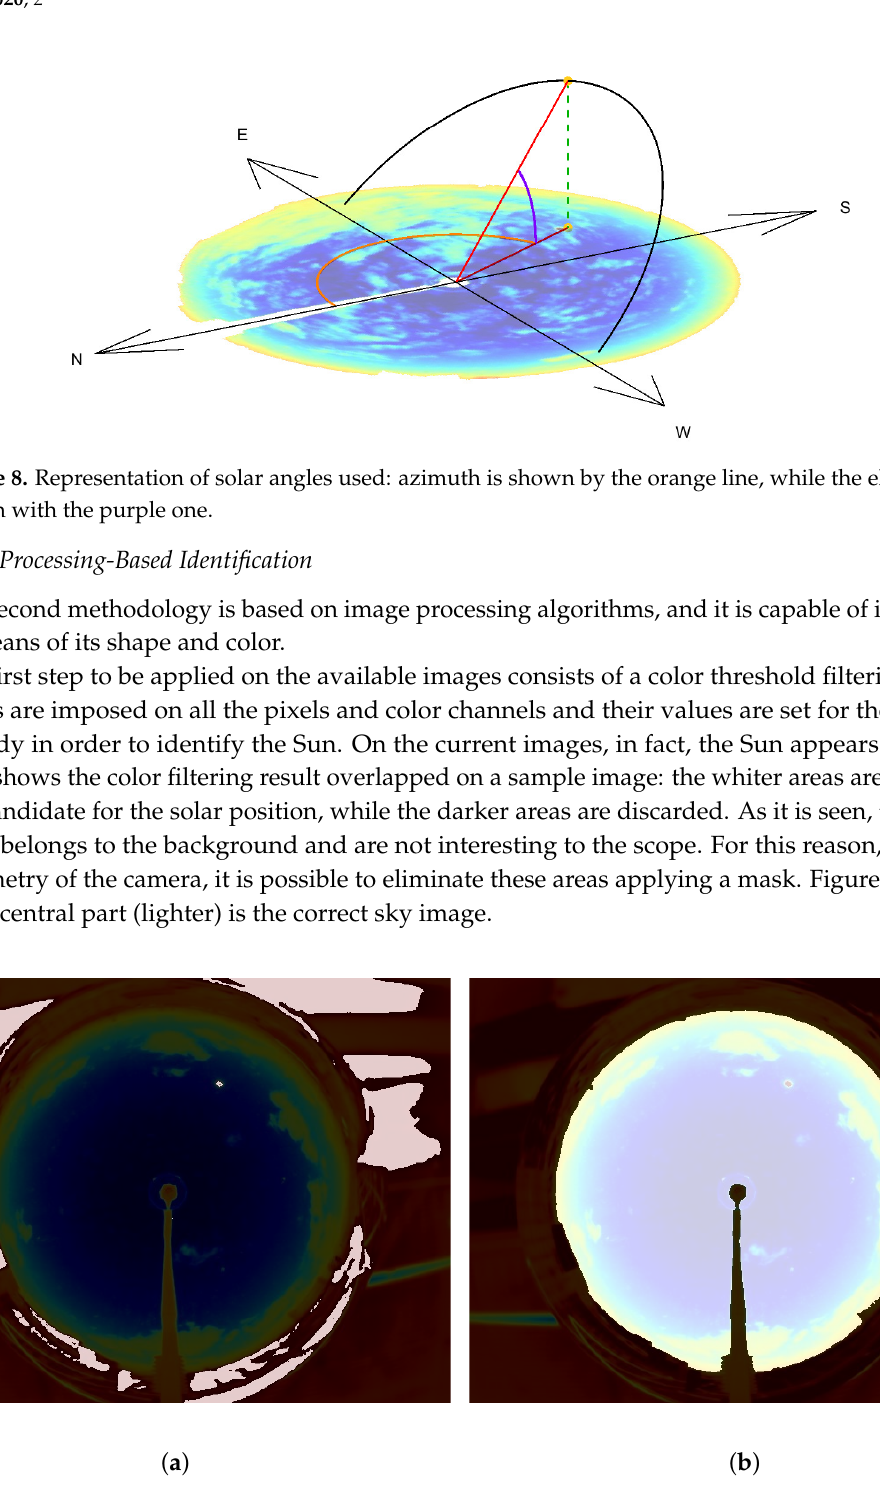
Figure 9. First two steps of image processing: ( a ) color thresholding filtering process and ( b ) background